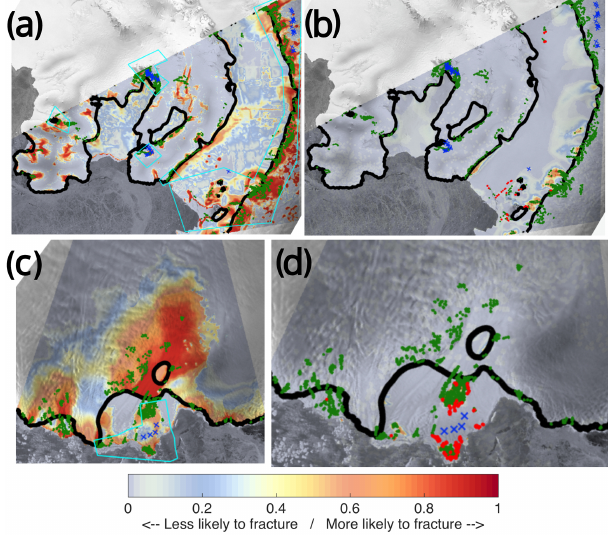
Figure 10. Modelled probability of a fracture vs. modelled damage for George IV IS (group 4) (a, b) and Dibble IS (group 3) (c, d) . Labels are the same as in Figs. 5 and 8.